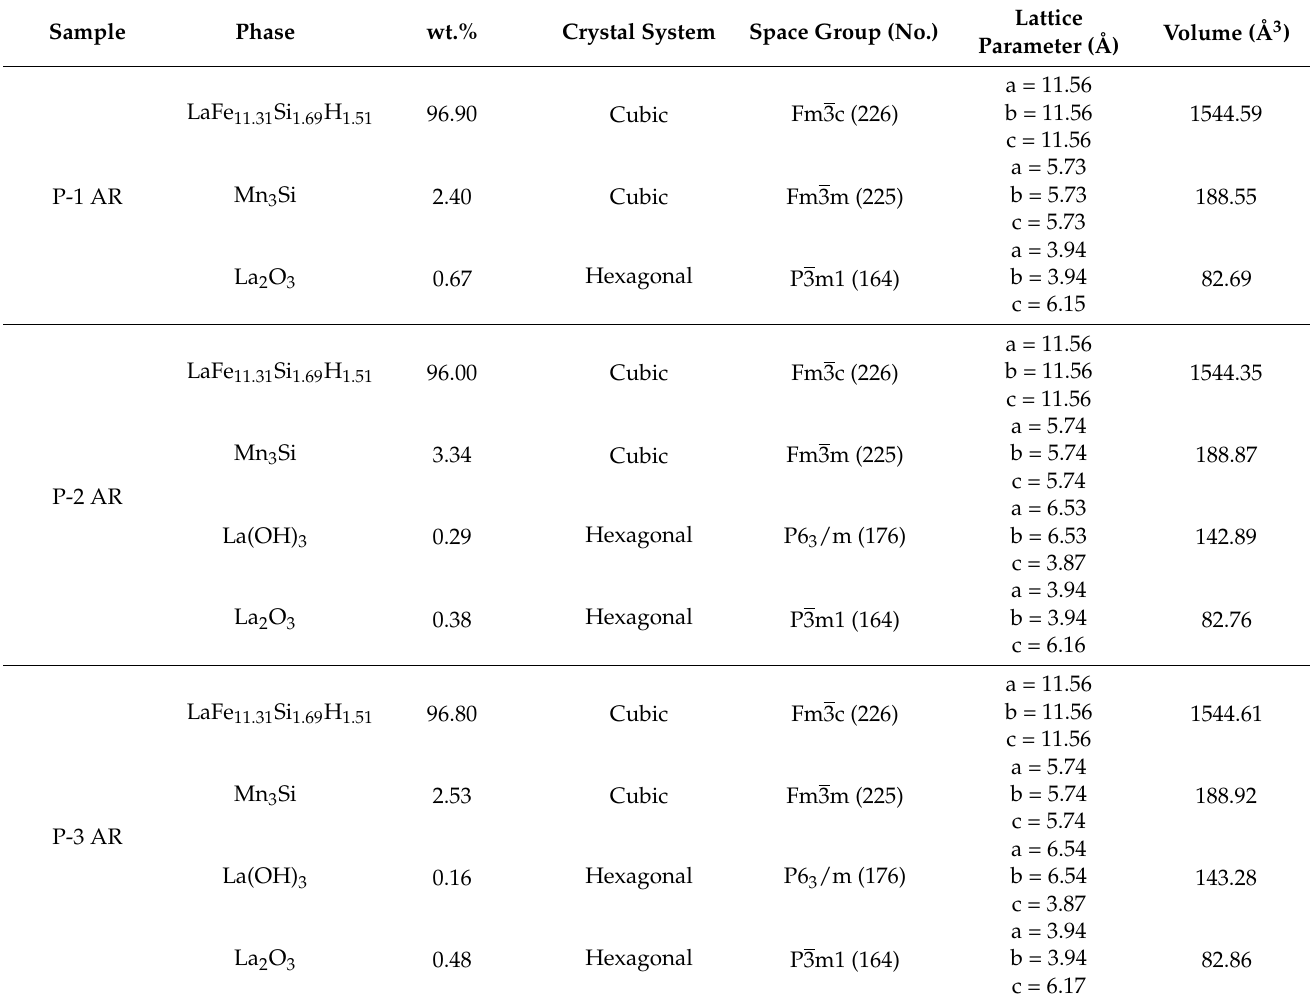
Table A1. Chemical composition of as-received (ground) powders P-1 AR–P-6 AR. All phase constituents are presented as wt.%.